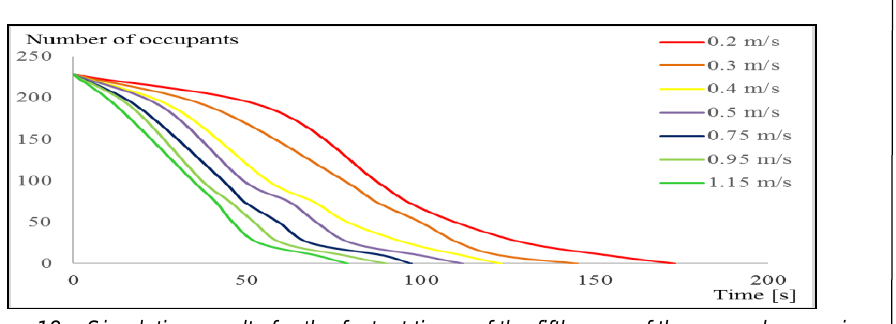
Figure 18 – Simulation results for the fastest times of the fifth case of the second scenario